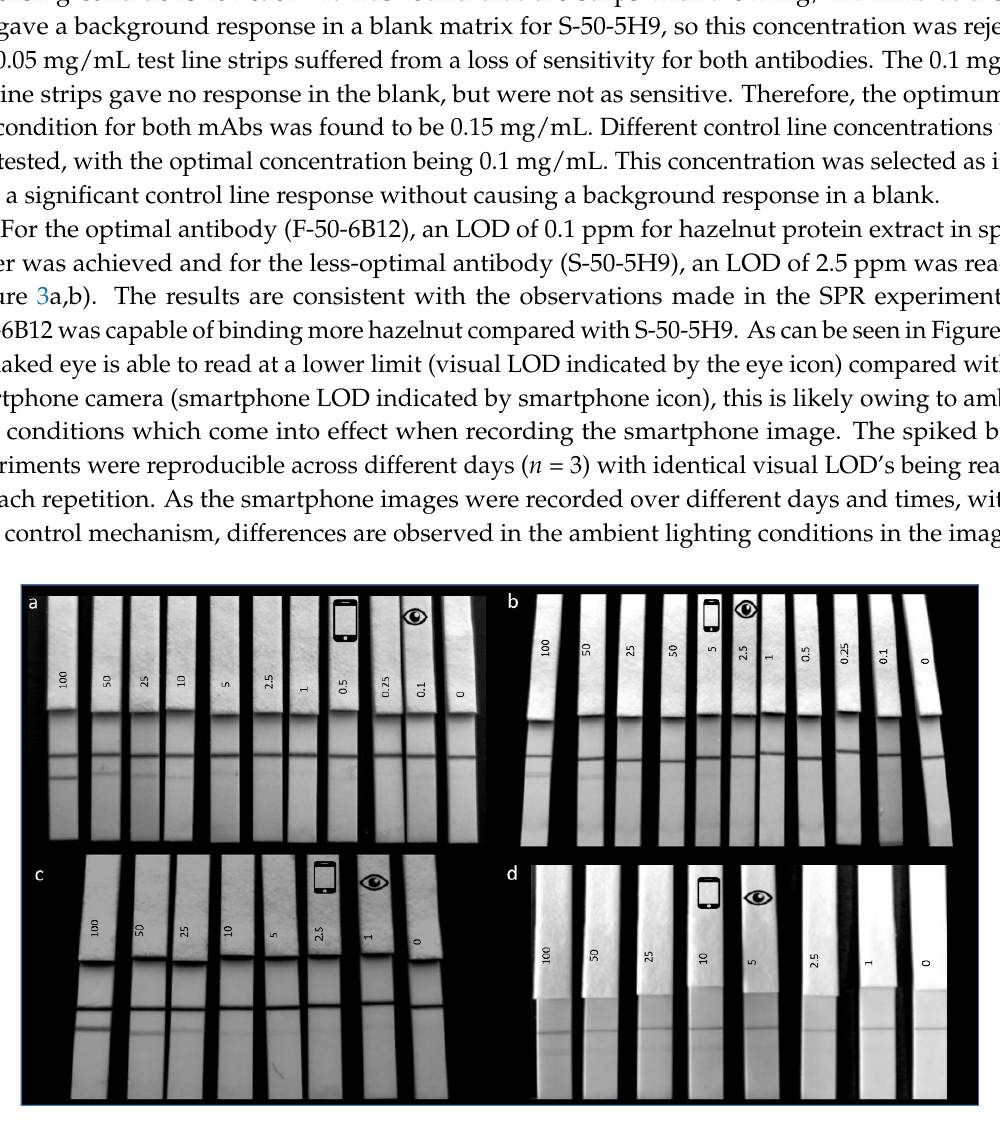
Figure 3. Lateral flow immunoassay limit of detection experiments. ( a ), F-50-6B12, ( b ), S-50-5H9: LFIAs showing the LOD determination of hazelnut protein extract spiked in PBS in the range of 100 ppm to 0.1 ppm with the last LFIA being a blank (0 ppm). In all LFIAs, the upper line is the control line and the lower line the test line. The visual LOD is indicated by the eye icon and the detection limit using a smartphone camera is indicated by the smartphone icon. ( c ), F-50-6B12, ( d ), S-50-5H9: LFIAs showing matrix LOD of hazelnut protein extract spiked in blank cookie extract (1:100 in running buffer) in the range of 100 ppm to 1 ppm (with the last strip representing a blank 0 ppm). The visual LOD is indicated by the eye icon and the detection limit using a smartphone camera is indicated by the smartphone icon.